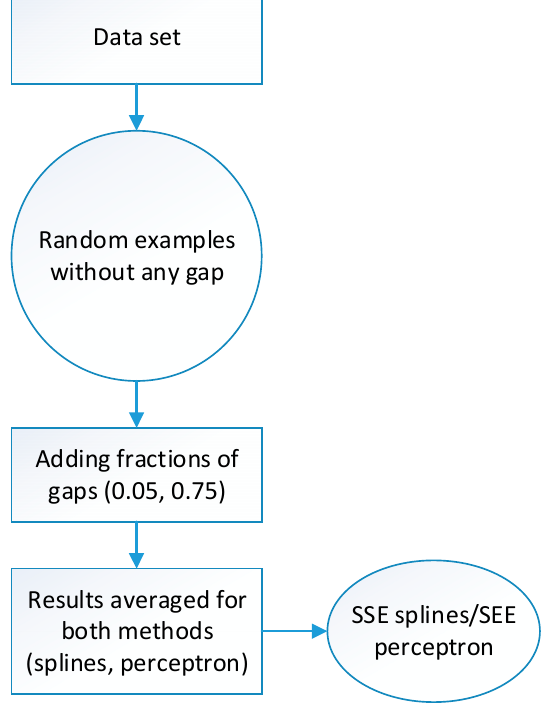
Figure 5. Block diagram followed in Test II.